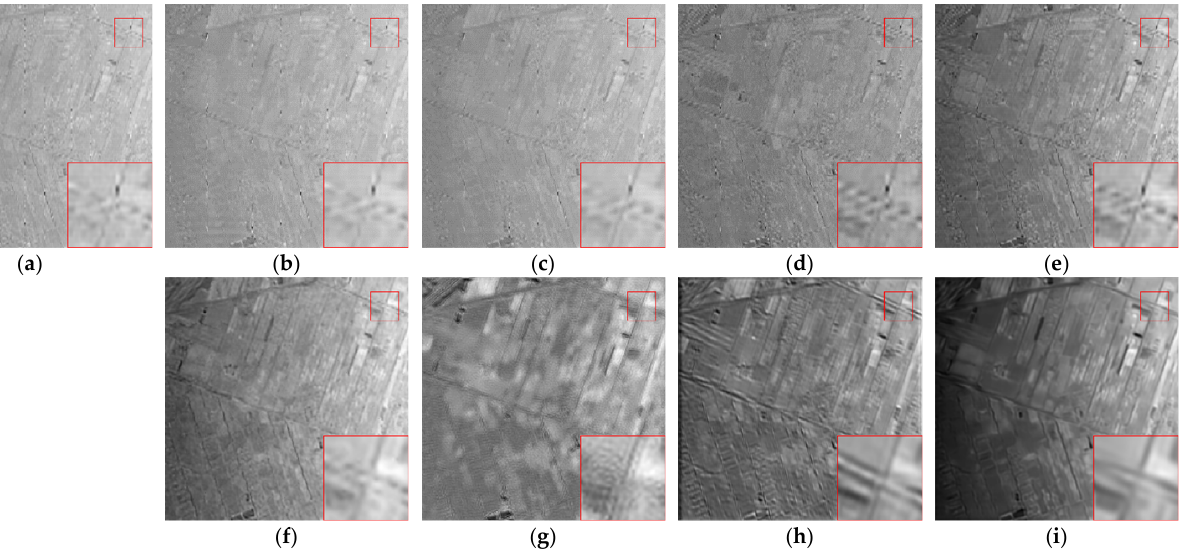
Figure 11. Recovery of bad lines by different denoising algorithms in band 83: ( a ) BM4D; ( b ) LRMR; ( c ) HyRes; ( d ) L1HyMixDe; ( e ) DHP-2D; ( f ) SIP; ( g ) SURE-CNN; and ( h ) 3S-HSID.